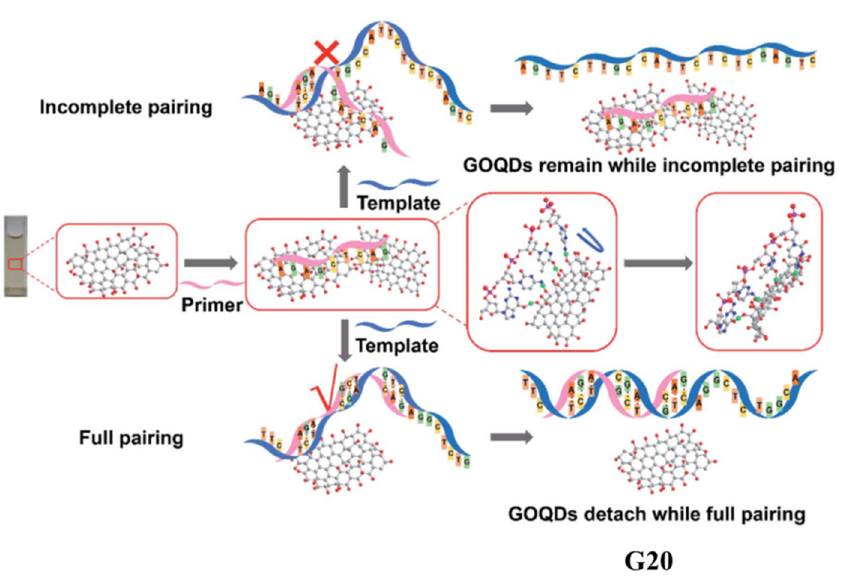
Figure 22. Schematic representation of the GOQDs ( G20 ) enhances the qRT-PCR specificity. Reprinted from [77] with permission from the Royal Society of Chemistry.